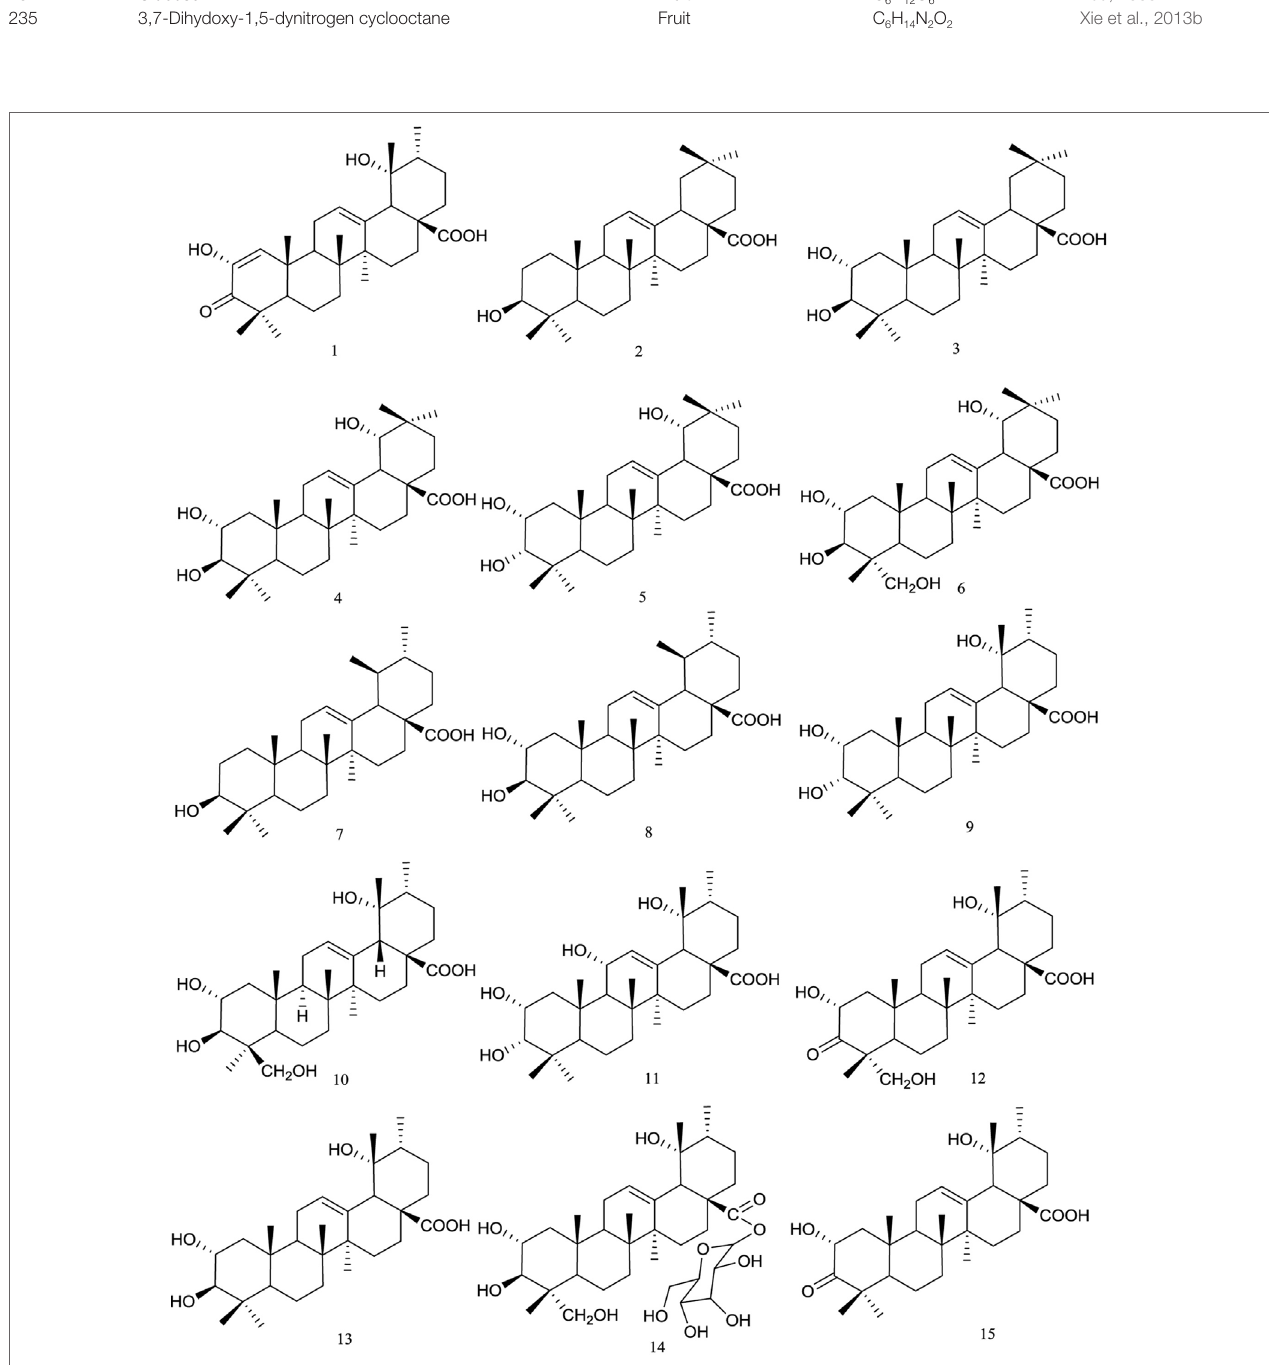
FIGURE 1 | Chemical structures of triterpenoids (1–15) isolated from R. chingii